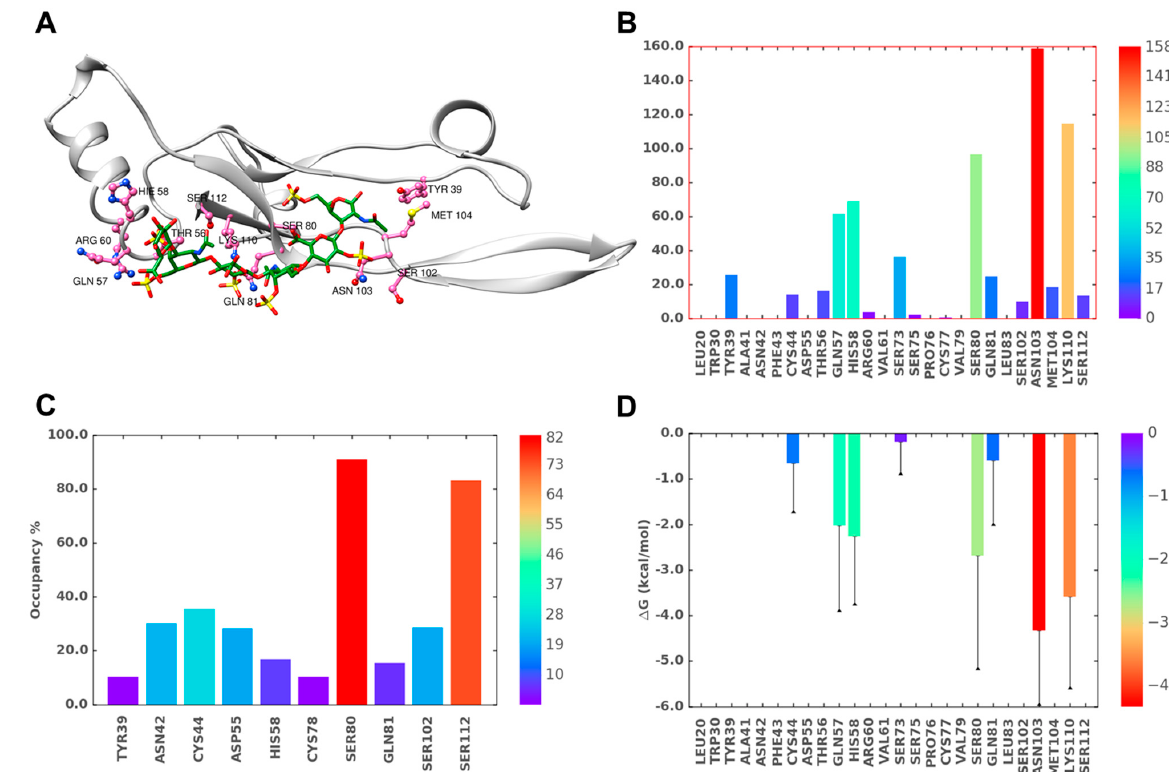
Figure 7. MD simulation of the TGF- β 2–CS06 interaction at binding site 2 (BS2). ( A ) A representative structure from the MD trajectory showing the hydrogen bonds (H-bonds) between TGF- β 2 residues (hot pink; ball and stick representation) and CS06 (green sticks). The protein ribbon is shown in light grey. ( B ) Inter-molecular H-bond formation in terms of % occupancy (proportion of MD frames showing direct H-bonds) for residues of BS2. ( C ) Proportion of water-mediated H-bonds (i.e., occupancy) between TGF- β 2 for residues in BS2 and CS06. ( D ) Single-residue energy decomposition (SRED) values for the TGF- β 2–CS06 complex for residues of BS2. Error bars show standard deviation. For ease of interpretation, values from lower to higher are represented by rainbow color (blue → red).